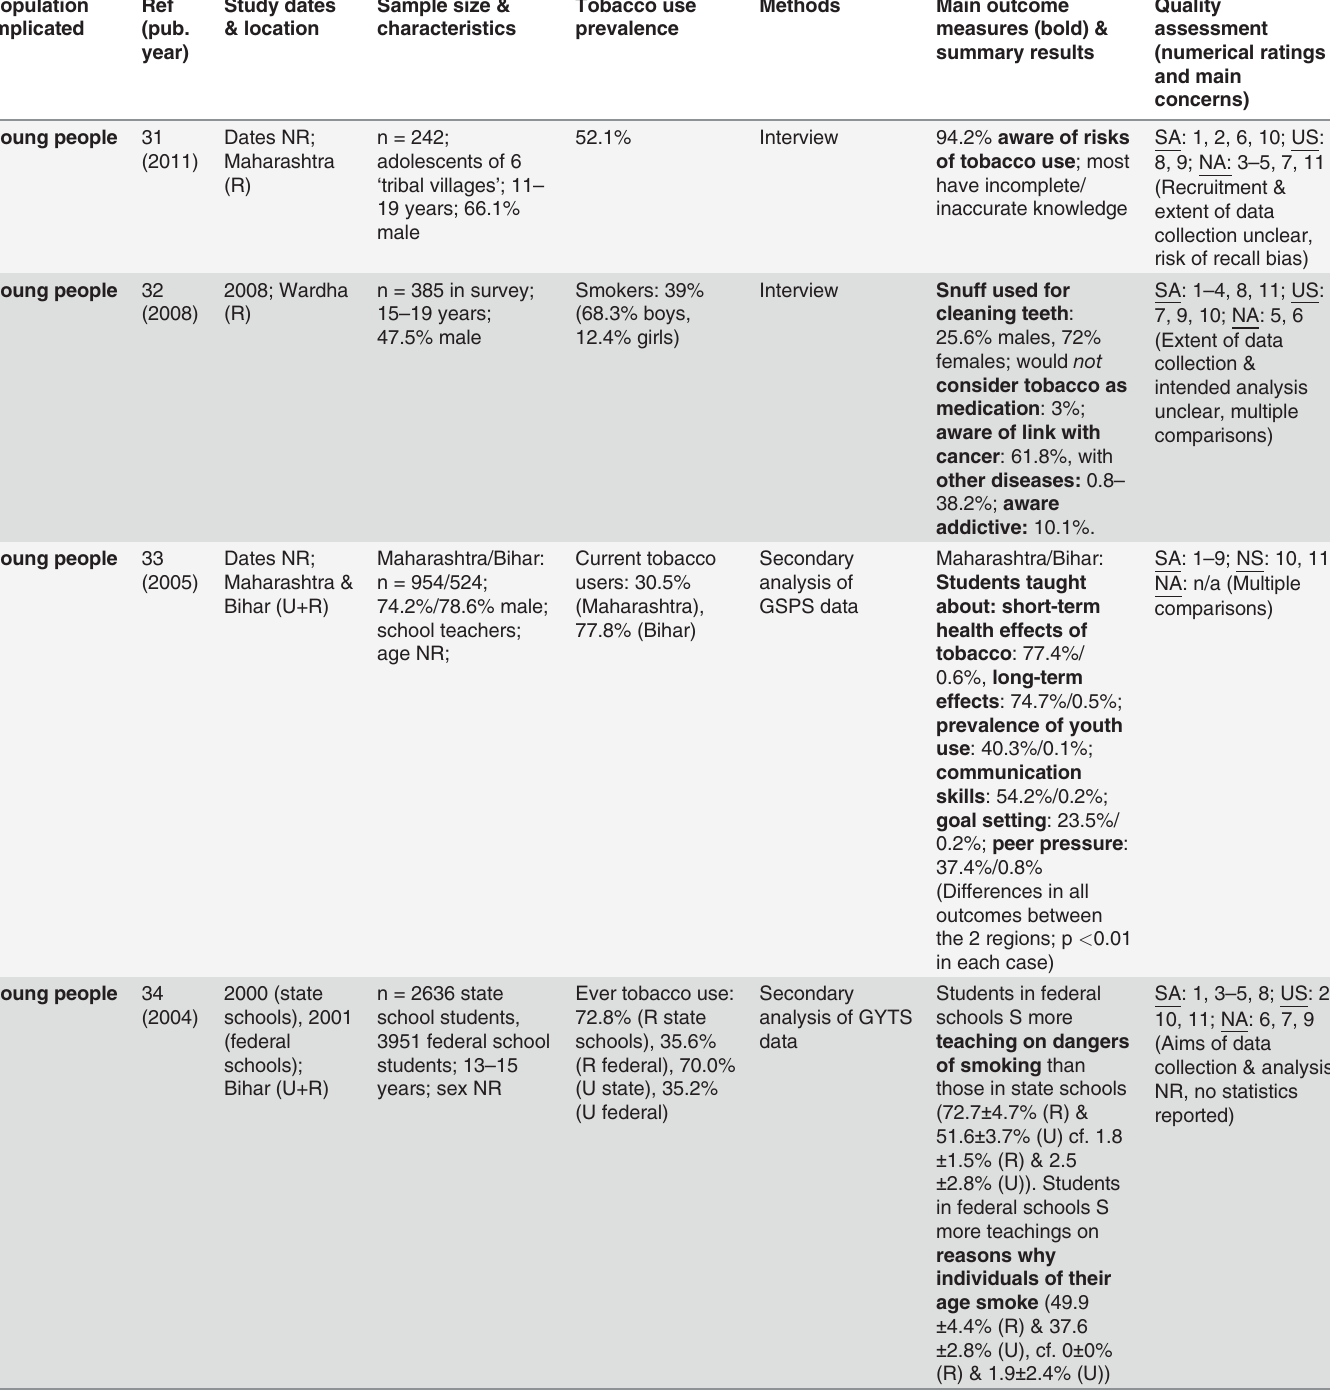
Table 5. Studies related to FCTC Article 12: Education, communication, training and public awareness. Population